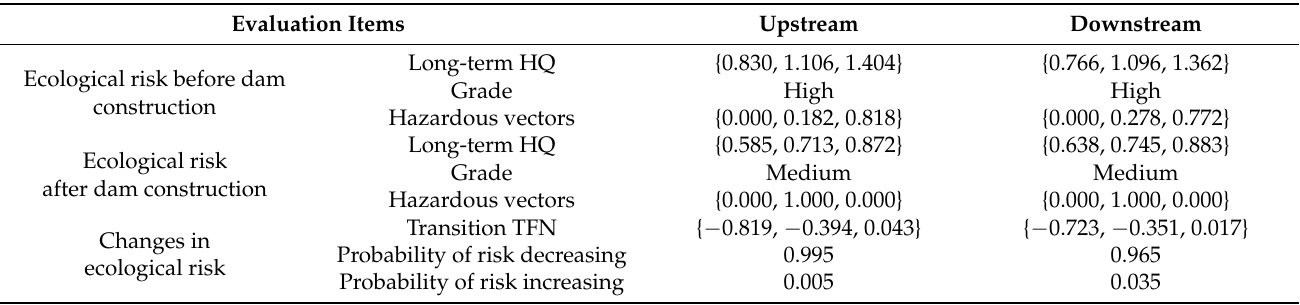
Table 3. Long-term HQ evaluation result of Cu based on the fuzzy HQ